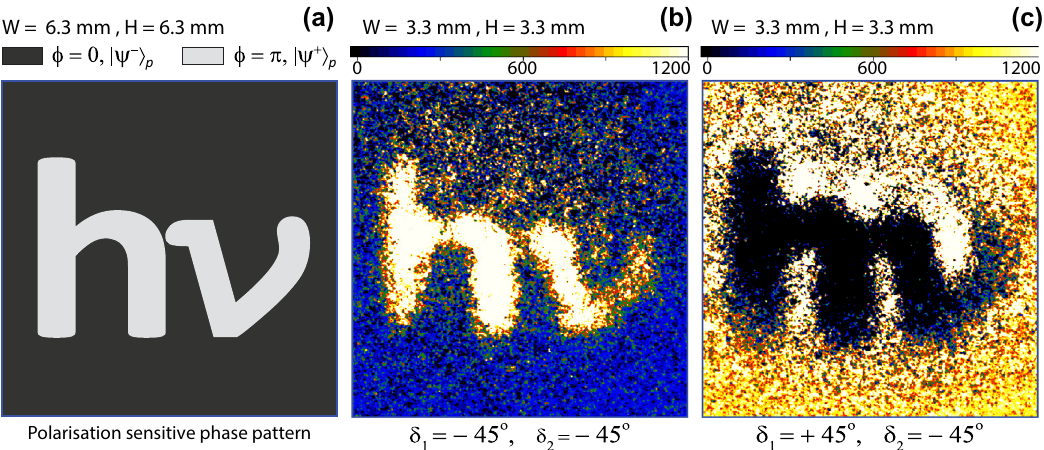
0 and a Figure 3. ( a ) A transparent polarisation sensitive phase pattern, a darker region represents φ( x 2 , y 2 ) = lighter region represents φ( x 2 , y 2 ) = π . ( b ) An image captured by ICCD camera, when measured polarisation d − d − states of photon-1 and photon-2 are 1 and 2 . ( c ) An image with inverted levels, when measured | � | � d + d − polarisation state of photon-1 is 1 and of photon-2 is 2 . Each image is captured for ten minutes time of | � | � (cid:31) entanglement parts of . In the first experiment, to produced a quantum image, both polarisers are aligned | � I 45 45 at δ 1 ◦ and δ 2 = − ◦ to detect a same state of polarisation of photons in the diagonal basis that is | d − � 1 = − d − of photon-1 and 2 of photon-2. Photon-1 is also measured in the quantum superposition basis of position. | � The experiment is repeated for this setting and an image, in the form of gated photon counts of the pattern, is accumulated for 10 minutes exposure of the ICCD camera. A background image is captured by displaying a 0 on the spatial light modulator with the same experimental setting. uniform grey level corresponding to φ = A coincidence photon image is constructed by subtracting a corresponding background image as shown in Fig. 3b. The ICCD camera also captures accidental counts in the coincidence window. These accidental counts are originated from the scattered photons and camera noise. These counts accumulate with the actual coincidence photon counts. A typical ratio of a coincidence to accidental counts is 0.35–0.45. This is why a background cor- rection is necessary. The noise of accidental photon counts in the background image, which is defined as a ratio of standard deviation to an average of counts for twenty-five hundred pixels is typically 0.12. All images shown in this paper are background corrected. Each image on the ICCD camera is reduced by 0.52 image demagnifica- 45 tion. In a similar experiment, polariser-1 is aligned at δ 1 ◦ to detect photon-1 in | d + � 1 and polariser-2 is = + 45 kept at δ 2 ◦ to detect photon in | d − � 2 . The coincidence image photon counts accumulated by the ICCD = − camera are shown in Fig. 3c, which corresponds to an image with inverted levels as compared to an image shown in Fig. 3b. This result is in agreement with Eq. (9) that shows an inversion of levels of images in the diagonal basis. These images are two-level images corresponding to the two-level phase shift of the pattern. In another experiment, a different transparent polarisation sensitive phase pattern as shown in Fig. 4a is displayed on the spatial light modulator. Where the gray levels corresponding to the position-dependent phase shifts are the same as in the previous pattern. A background-corrected image of this pattern shown in Fig. 4b is 45 δ 2 accumulated with the ICCD camera for 10 minutes time of exposure in the diagonal basis, for δ 1 ◦ = = − and with a lens L o . This image is then compared with another background-corrected image captured with a dif- 90 ferent setting of polariser-1, δ 1 ◦ as shown in Fig. 4c keeping all other settings the same. According to the = + theoretical analysis shown in the previous section, the coincidence probability corresponding to a measurement H V of or state of photon-1 does not contain the phase information of the pattern therefore, no image should | � | � V H be formed. A measurement of photon-1 polarisation state in 1 collapses photon-2 polarisation state onto 2 | � | � H e i φ( x 2 , y 2 ) H and this polarisation state is transformed by the spatial light modulator such that 2 2 . This is | � → | � a pure phase pattern and it diffracts photons. However, a telescope is located at a far distance 15.24 m from the pattern and its spatial resolution at this distance is about 0.3 mm, where the size of each square in the pattern ∼ is 1 mm 1 mm. Due to the finite lens diameter, the telescope is not capturing all the diffracted photons carrying × information of sharp edges and it leads to the fundamental diffraction limit of resolution. Thus, the edges or phase boundaries in the pattern lead to low two-photon coincidence counts. Therefore, the edges appear as low-level regions in the image. In this case, if all diffracted photons are also captured then no image of the pattern will result. This effect is exactly matching for all the sharp edges by a comparison of an image shown in Fig. 4c with a 0 to detect photon-1 in H corresponding image shown in Fig. 4b. Another image is captured for setting, δ 1 1 = | � keeping all other settings the same as for the image shown in Fig. 4b. Since this setting collapses the polarisation V state of photon-2 to 2 and this quantum state remains unchanged by the spatial light modulator therefore, no | � 90 pattern is formed on ICCD camera as shown in Fig. 4d. A similar experiment is repeated for δ 1 ◦ to detect = 45 V 1 and δ 2 ◦ to detect | d − � 2 for a pattern shown in Fig. 3a. A corresponding background-corrected image = − | � is shown in Fig. 5a, where the sharp edges appear due to the diffraction limit of the telescope. As explained, for 0 and δ 2 45 δ 1 ◦ , no pattern is formed as shown in Fig. 5b. A single photon background-corrected image = = −